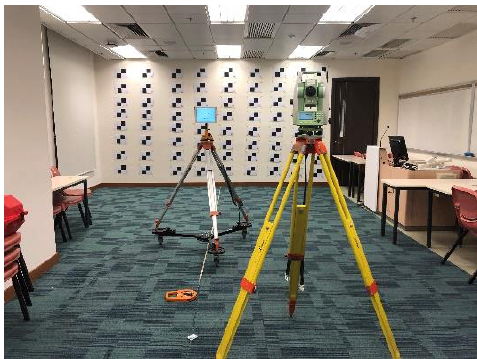
Figure 10. Test field and equipment setup for the first experiment.